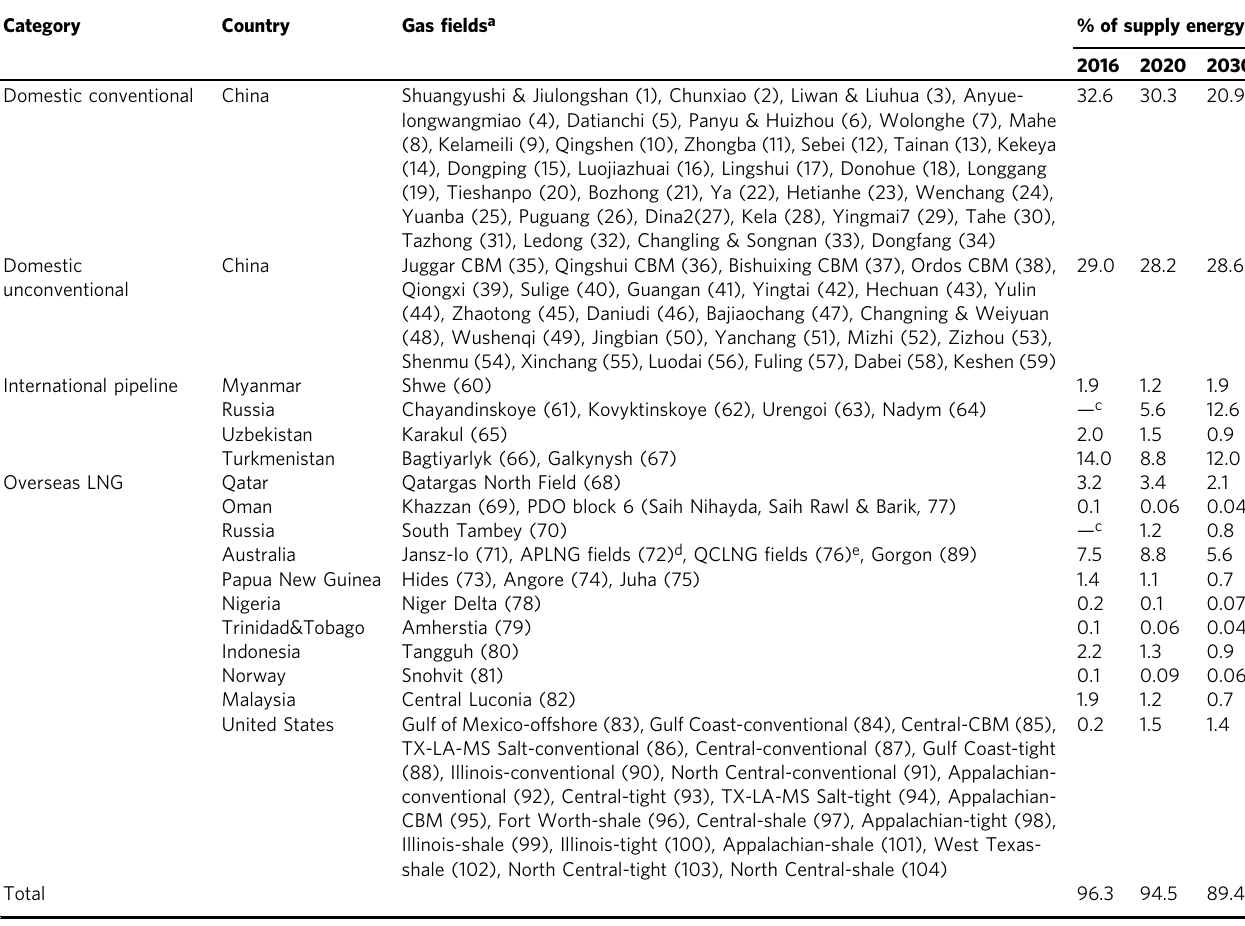
Table 1 Global natural gas supplies to